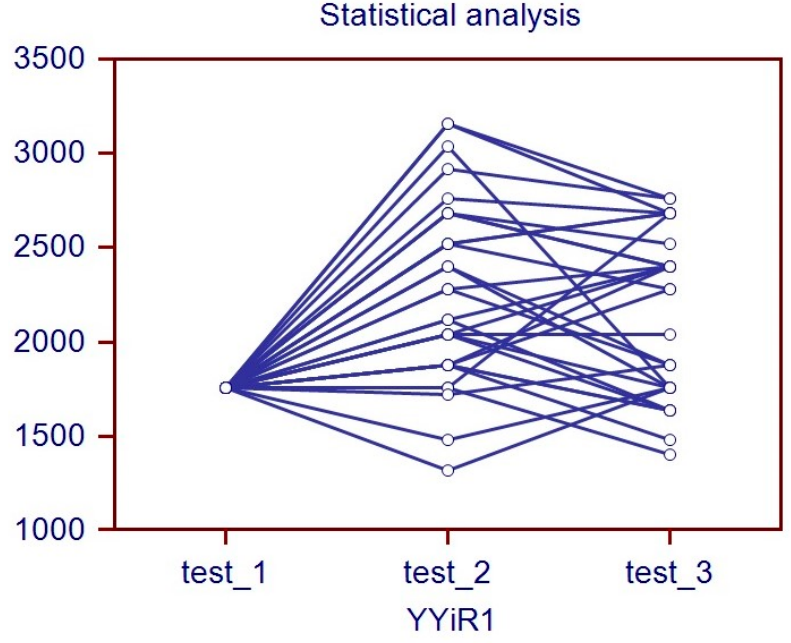
Figure 1. Statistical analysis. Wilcoxon test results → Meters obtained at YYiR1.